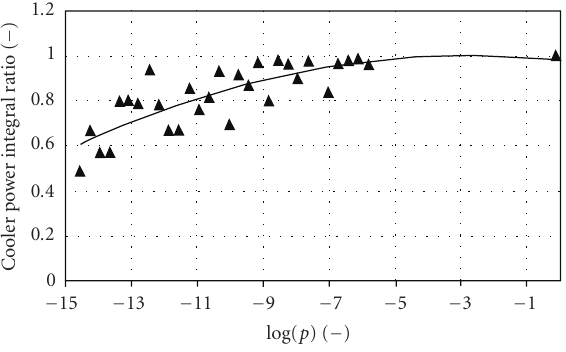
Figure 24: Probability distribution for the performance indicator: integral power ratio exchanged in the cooler.